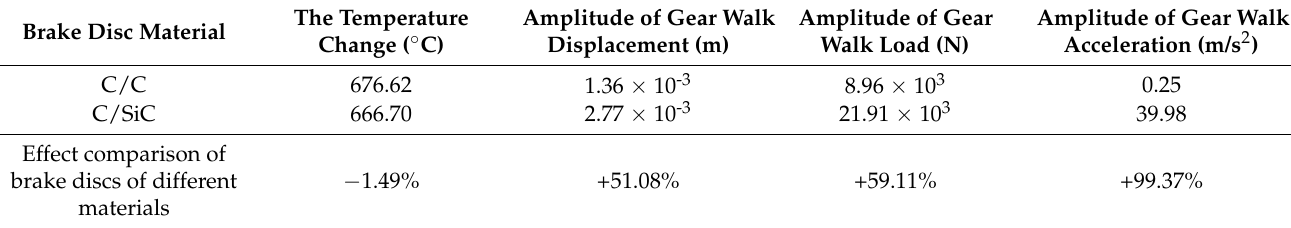
Table 2. Effect analysis of brake disc